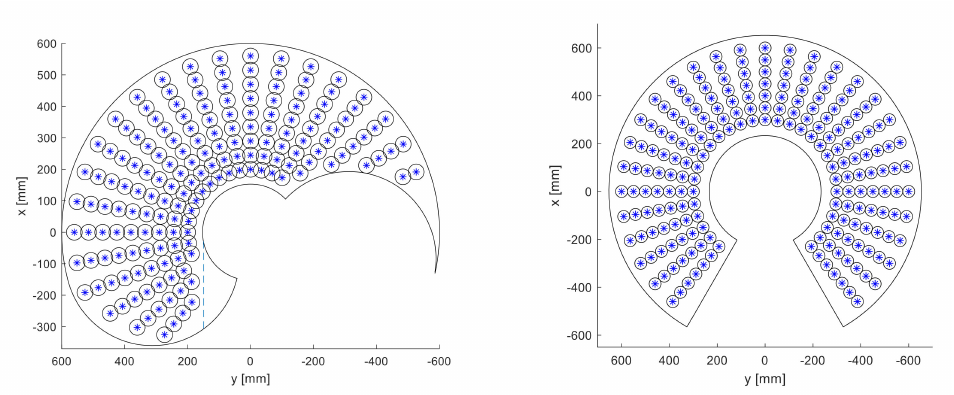
Figure 6. Point sets in which the experimental analyses were performed for the SCARA robot ( left ) and the articulated robot ( right ).